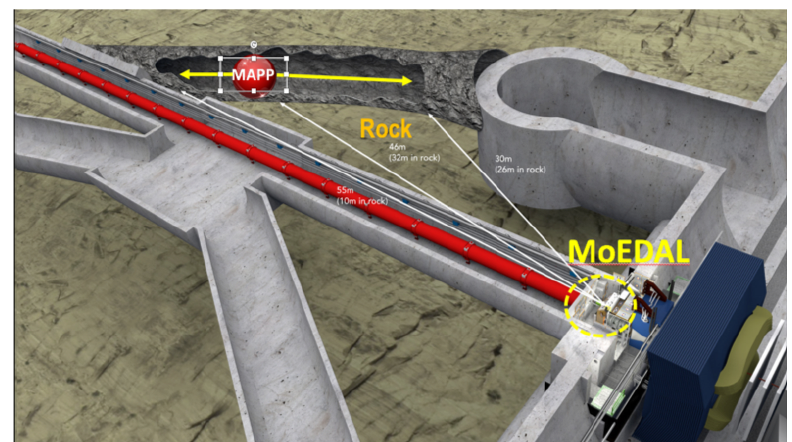
Figure 8. A sketch of the MAPP sub-detector.